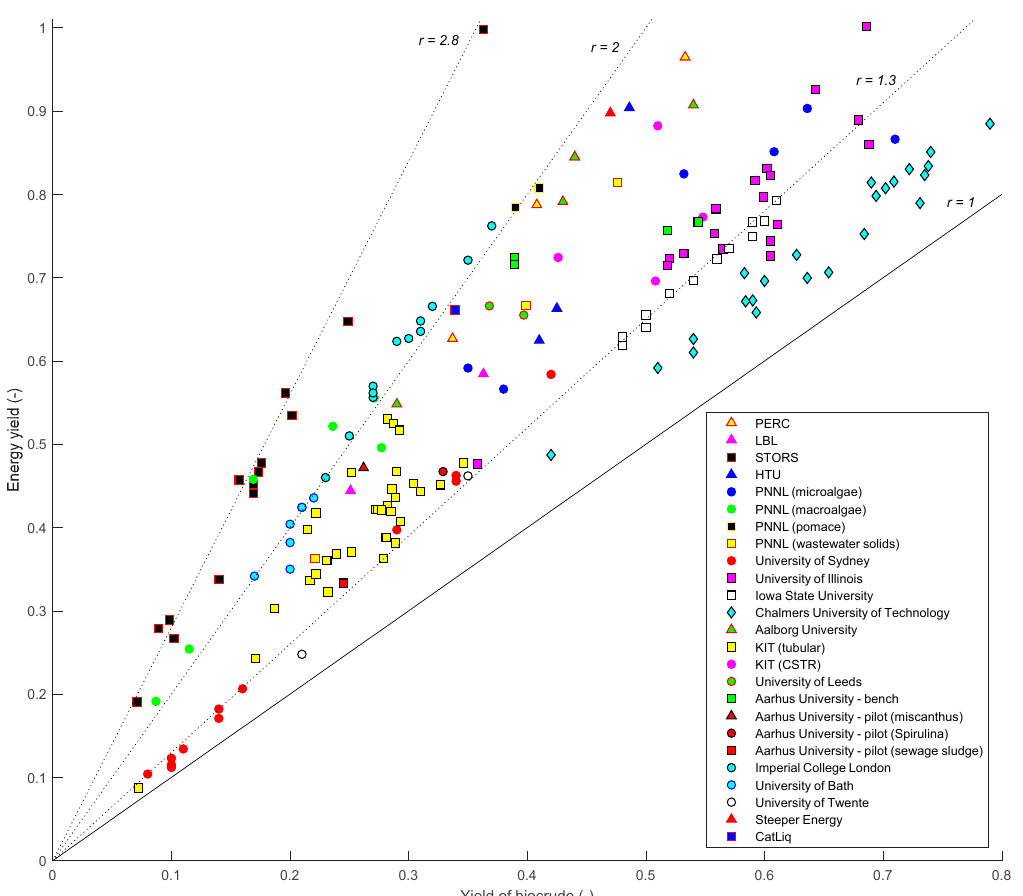
Figure 9. Energy ratio vs. bio-crude yields for the continuous HTL studies in the open literature. Same symbolic nomenclature as in Figure 7.